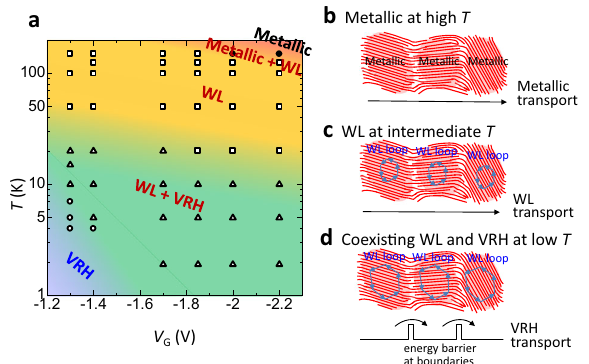
Fig. 4 T – V G schematic diagram and schematic conduction mechanism at each regime. a A temperature T vs. gate voltage V G schematic diagram of the conduction mechanism consisting of effectively metallic, effectively metallic + weak localization (WL), WL, WL + variable-range hopping (VRH), and VRH regions, based on the magnetoconductivity (MC) measurements. The closed circles, open rectangles, open triangles, and open circles represent the experimental points at which effectively metallic, WL, mixed WL and VRH, and pure VRH behaviors were observed in the MC measurements. MC data other than those shown in Fig. 3 are summarized in Supplementary Note 2, Supplementary Figs. 1 and 2. b – d Schematic of the poly(2,5 bis (3-hexadecylthiophene-2-yl)thieno[3,2- b]thiophene) (pBTTT) fi lm structure consisting of crystalline domains and boundaries surrounding them and the transport mechanism at each temperature range. Pink circles and red lines represent the crystalline domains and polymer chains, respectively. At high temperatures, each crystallite is connected to allow macroscopic delocalized transport, either b effectively metallic or c WL. The WL conduction occurs when a localized loop path (blue arrows) is formed within the crystallite. d At low temperatures, coherency of the conduction across boundaries is lost and each crystallite is isolated by barriers through which VRH conduction